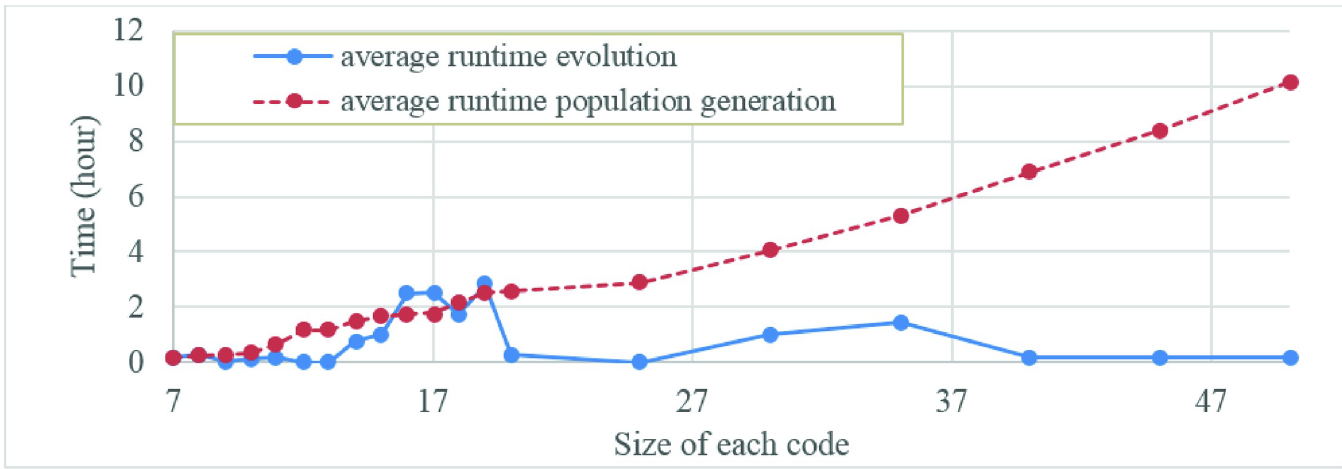
Fig 7. Evolution and generation runtimes during search for various sizes of zero-scored 1D code.